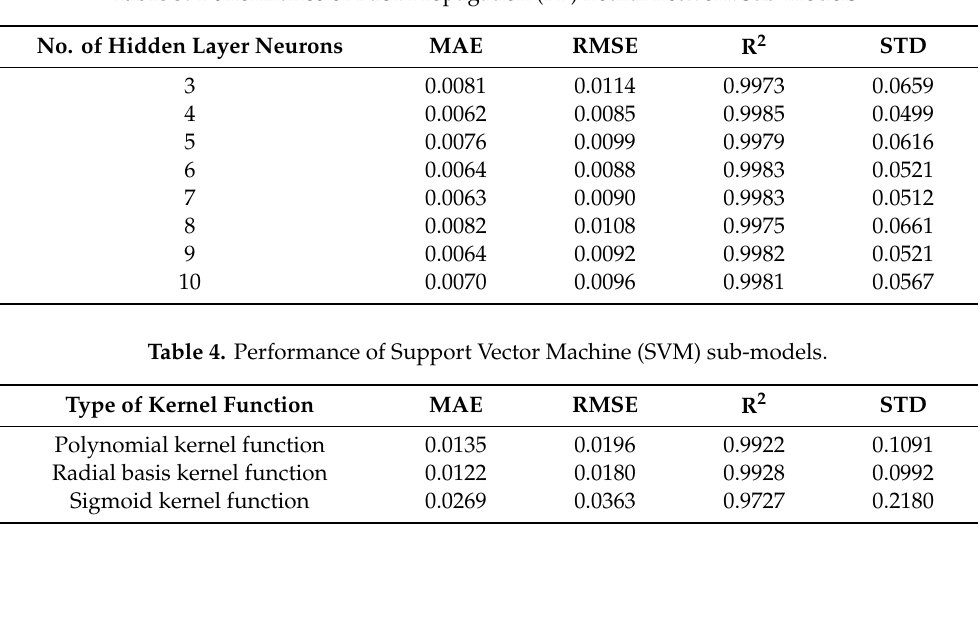
Table 3. Performance of Back Propagation (BP) neural network sub-models.